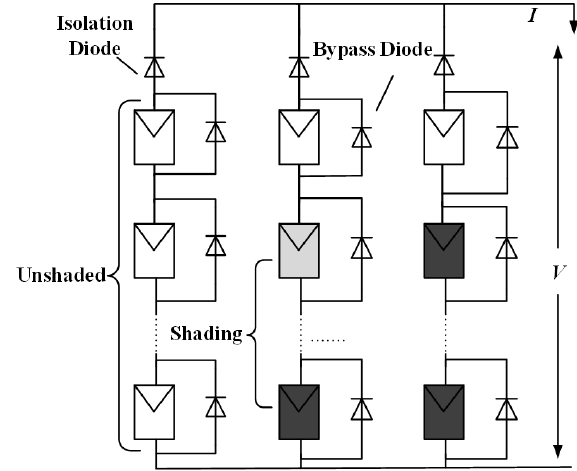
Fig. 1. PV module under uniform light and partial